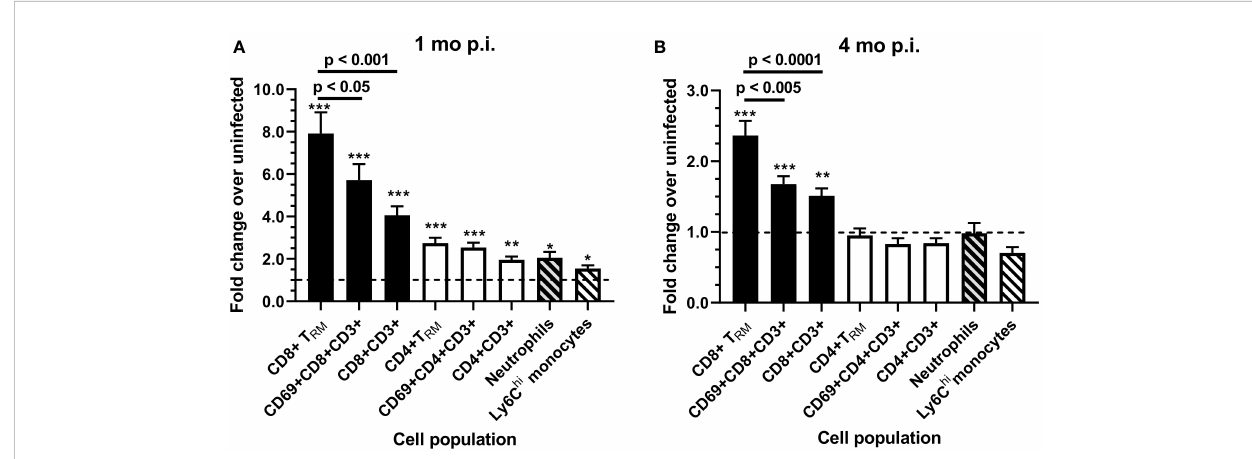
FIGURE 7 Fold changes of brain leukocytes 1 and 4 months after infection with Lm 10403s. Brain leukocytes collected from uninfected mice and from mice infected with Lm 10403s were quanti fi ed as described in Figure 6. Leukocytes from perfused brains were analyzed by fl ow cytometry and numbers of cells/brain calculated. Fold-changes for numbers of cells were calculated 1 mo (A) and 4 mo (B) , respectively, from infected mice (12, 12) over uninfected mice (6, 8) for each population and are represented as the mean + SEM fold change. Statistical differences between cell numbers from 10403s-infected and uninfected mice groups at 1 and 4 mo were calculated via 2-tailed Student ’ s t -test. *p < 0.05, **p < 0.01, ***p < 0.001. Signi fi cance among cell populations at the same time points were calculated via 1-way ANOVA with Tukey ’ s post-test and are